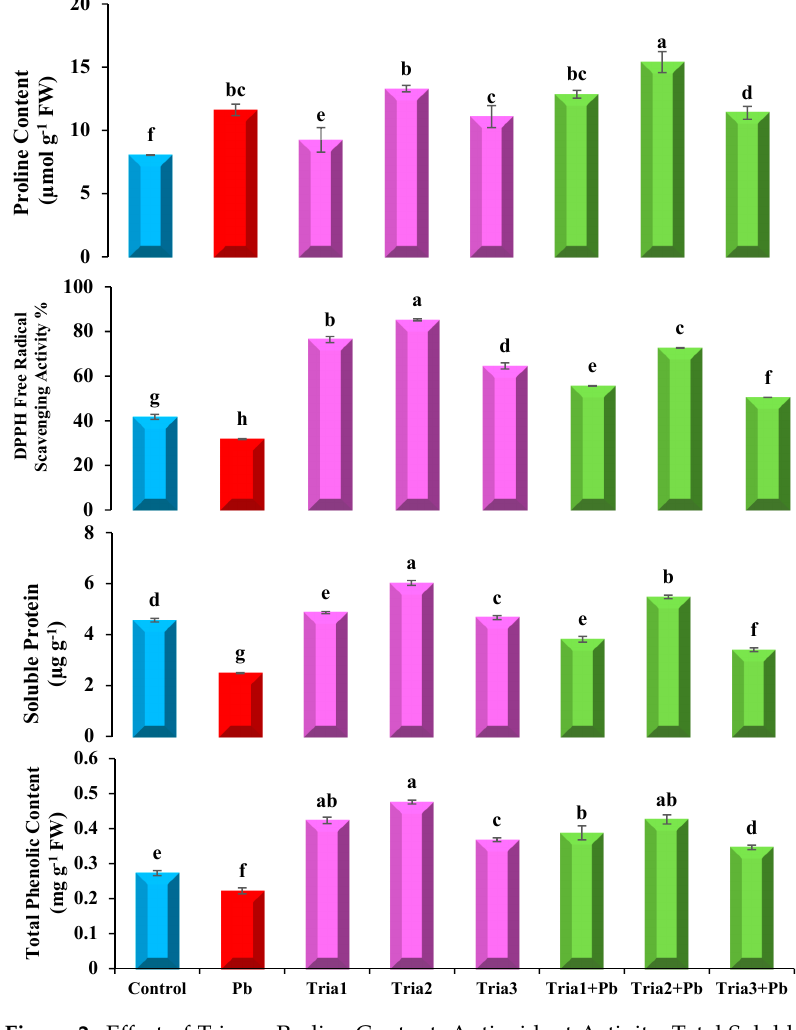
Figure 2. Effect of Tria on Proline Content, Antioxidant Activity, Total Soluble Protein and Total Phenolic Content of Phaseolus vulgaris L. under Pb stress. (Data exhibit means ± SE of 4 replicates. Non-identical letters specify significant difference amid the treatments at p ≤ 0.05. Control, Pb = 400 mg kg − 1 Pb, Tria-1 = 10 µmol L − 1 of Tria, Tria-2 = 20 µmol L − 1 of Tria, Tria-3 = 30 µmol L − 1 of Tria.